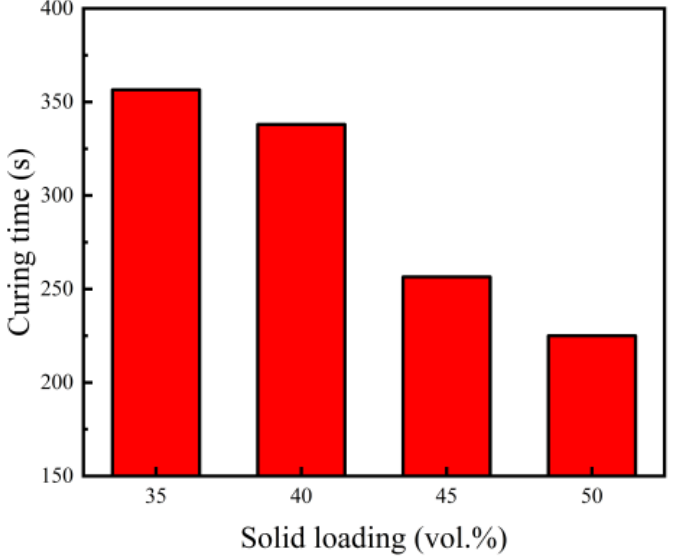
Figure 5. Effect of solid loading on the curing time.